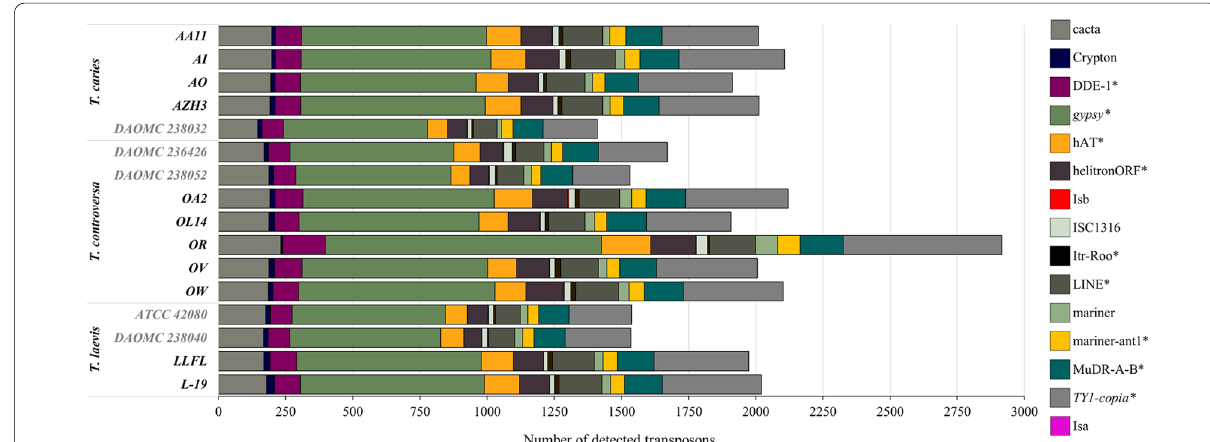
Fig. 2 Number of detected transposable elements and their classification in 16 isolates of common and dwarf bunt. Significant differences in the total number of detected transposable elements between sequenced genomes of this study (black font) and publicly available ones are marked with * (Tukey HSD, α 0.001) =